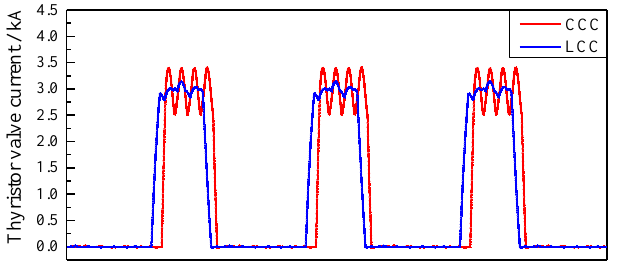
Figure 9. Comparison of the thyristor valve currents between the CCC and the LCC.